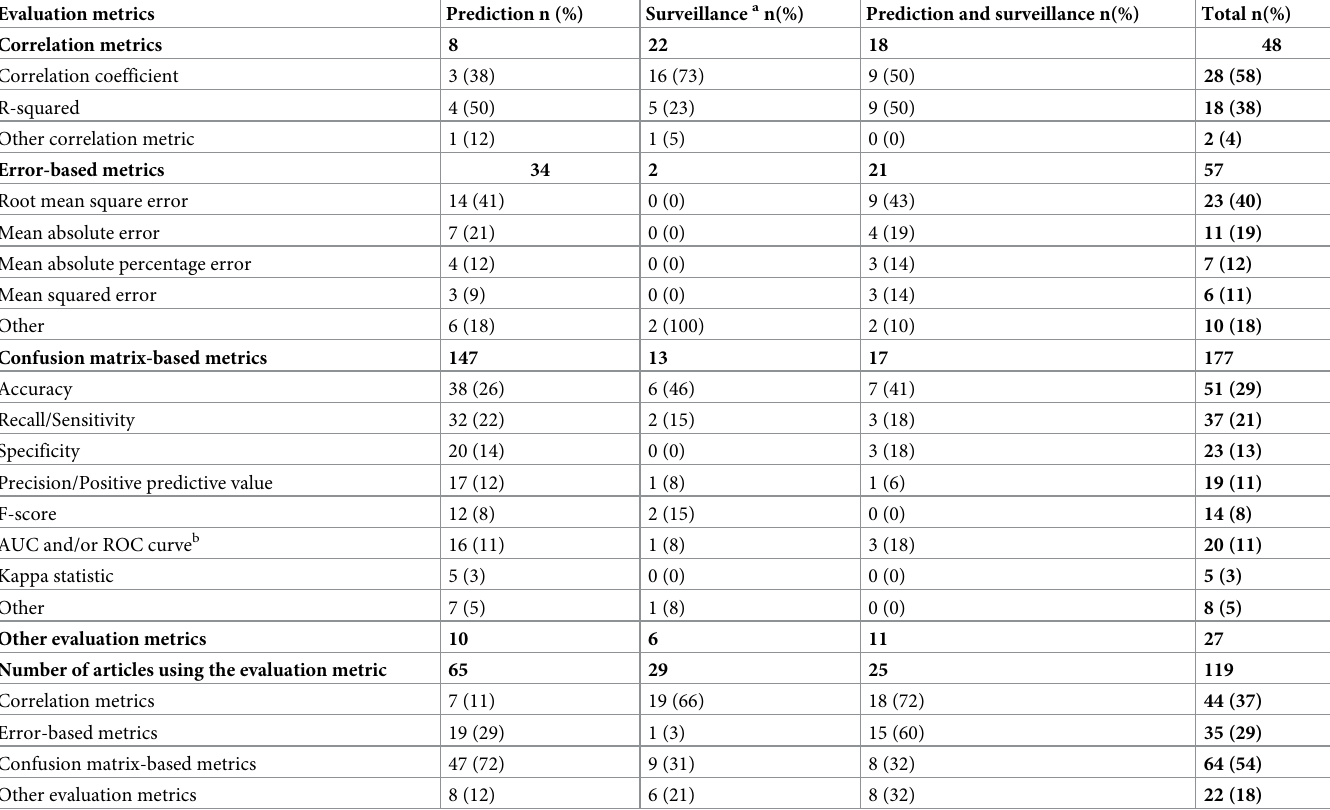
Table 4. Evaluation metrics used in the selected articles depending on their aim(s) � .